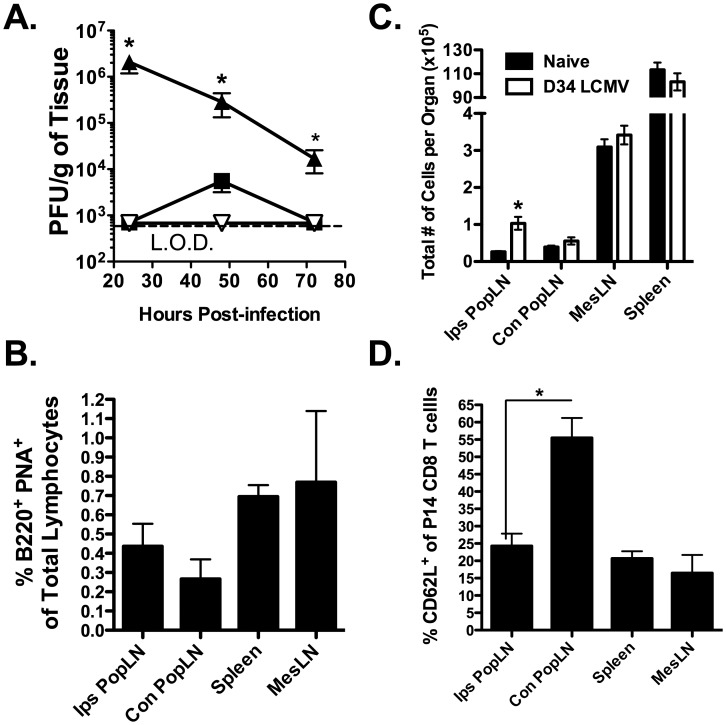
High frequencies of CD62L− LCMV-specific CD8 T cells in the draining LN is not unique to the MedLN.C57BL/6 mice were infected in the footpad with LCMV. (A) Viral titers in the Ips PopLN (solid upwards triangle), Con PopLN (downwards triangle) and spleen (solid square) were measured via plaque assay at 24, 48 and 72 h p.i.. *, Ips PopLN is significantly greater (p<0.05) than all other as determined by ANOVA. (B and D) Naïve Thy1.1+ P14 CD8 T cells were adoptively transferred into naïve Thy1.2+ recipients and infected via the footpad with LCMV the following day 34–40 p.i., the indicated tissues were harvested and assessed for the frequency (B) GC B cells (as described in Figure 5) and (D) CD62L+ P14 CD8 T cells. (C) The total number of cells in each LN or spleen was assessed in naïve mice or in mice previously infected (day 34–40) with LCMV via the footpad. (B and C) *, Day 34 Ips PopLN is significantly greater (p<0.05) than naïve Ips PopLN determined by ANOVA. (D) *, Ips PopLN is significantly lower (p<0.05) than Con PopLN as determined by ANOVA. Combined data from 2–3 individual experiments with four mice per group. Error bars represent the standard error of the mean.